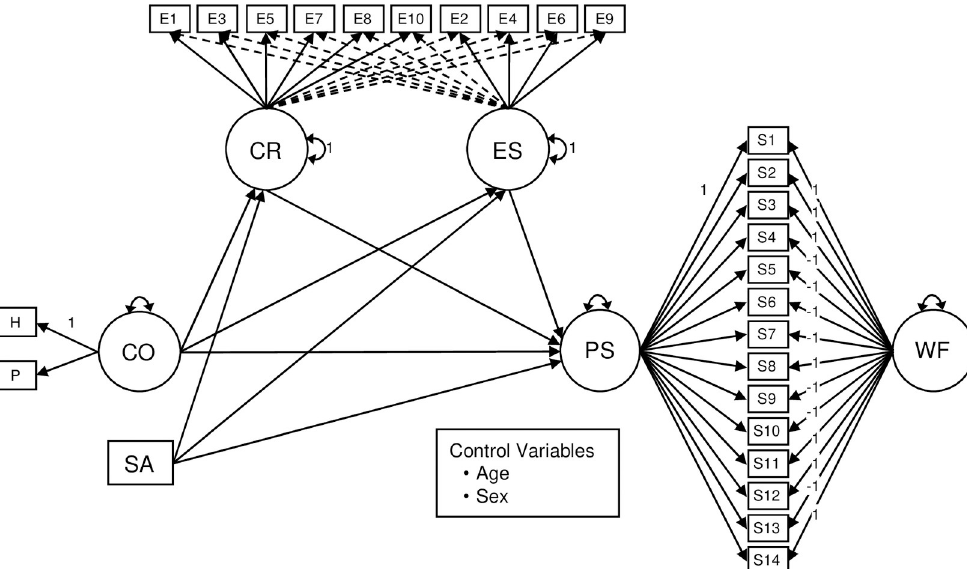
Fig 1. SEM model evaluating the mediating effects of emotional regulation on the impact of COVID-19 contact and equipment safety on the perceived stress of medical personnel. Note . CO = contact with COVID-19 patients; SA = perceived safety provided by the protective equipment; PS = perceived stress; CR = cognitive regulation; ES = emotional suppression; WF = wording factor; H = daily number of hours treating COVID-19 patients; P = daily number of COVID-19 patients treated; S1-S14 = Perceived Stress Scale items; E1-E10 = Emotional Regulation Questionnaire items. Squares represent observed variables. Circles represent latent variables. Full unidirectional arrows linking circles and rectangles represent the target factor loadings. Dotted unidirectional arrows linking circles and rectangles represent the cross-loadings. Bidirectional arrows connecting a single circle represent the factor variances. For simplicity, the control variables do not appear represented in the model, as well as the item uniquenesses, the factor uniquenesses, and the residual correlations between variables that share the same predictors.